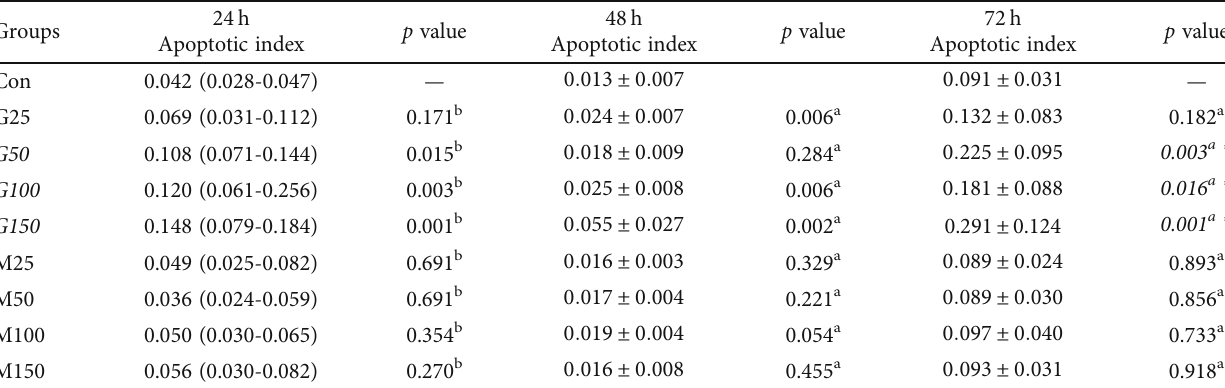
Table 2: Apoptotic index in RGCs at 24h, 48h, and 72h.